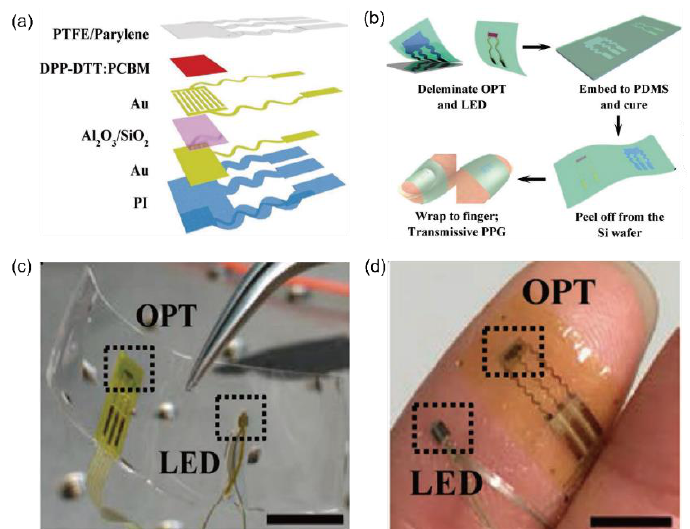
Figure 14. ( a ) Schematic of the device structure of the flexible NIR organic phototransistor (OPT). ( b ) Process diagram of fabricating a flexible hPPG sensor and applying to the finger. ( c ) The image of the flexible sensor in the peel-off state during the process. ( d ) Image of a finger attached with the epidermal NIR hybrid PPG (hPPG) sensor (scale bar, 5 mm). Adapted with permission from [40], Wiley, 2017.